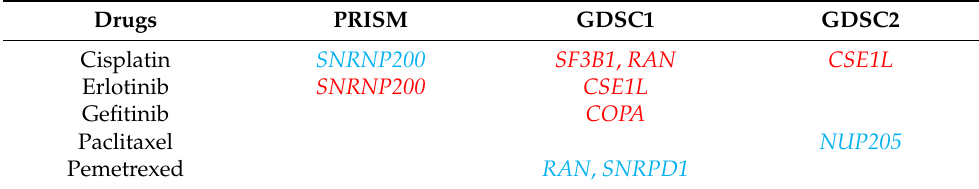
Table 5. Hsa-142-3p targeted proliferation genes (shown in Figure 5C) with a significant differential expression ( p < 0.05; two-sample t -tests) in sensitive versus resistant CCLE NSCLC cell lines to specific drugs. Drug activity measurements include IC 50 , EC 50 , ln(IC 50 ), and ln(EC 50 ). Red font indicates that the gene has a higher expression in the resistant cell lines than in the sensitive cell lines. Blue font indicates the gene has a lower expression in the resistant cell lines than in the sensitive cell